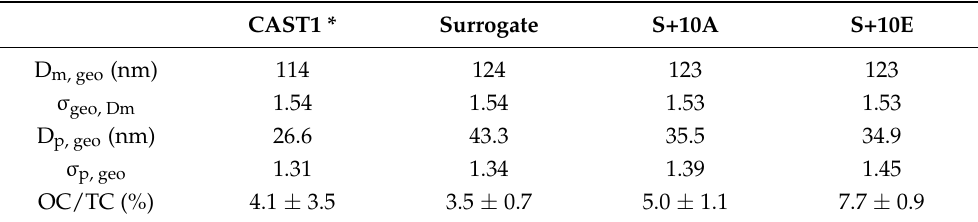
Table 2. Size distribution and morphological parameters of the four studied aerosols. (A) CAST1; (B) gasoline Surrogate; (C) Surrogate anisole (S+A); and (D) Surrogate ethanol (S+E). * Values from